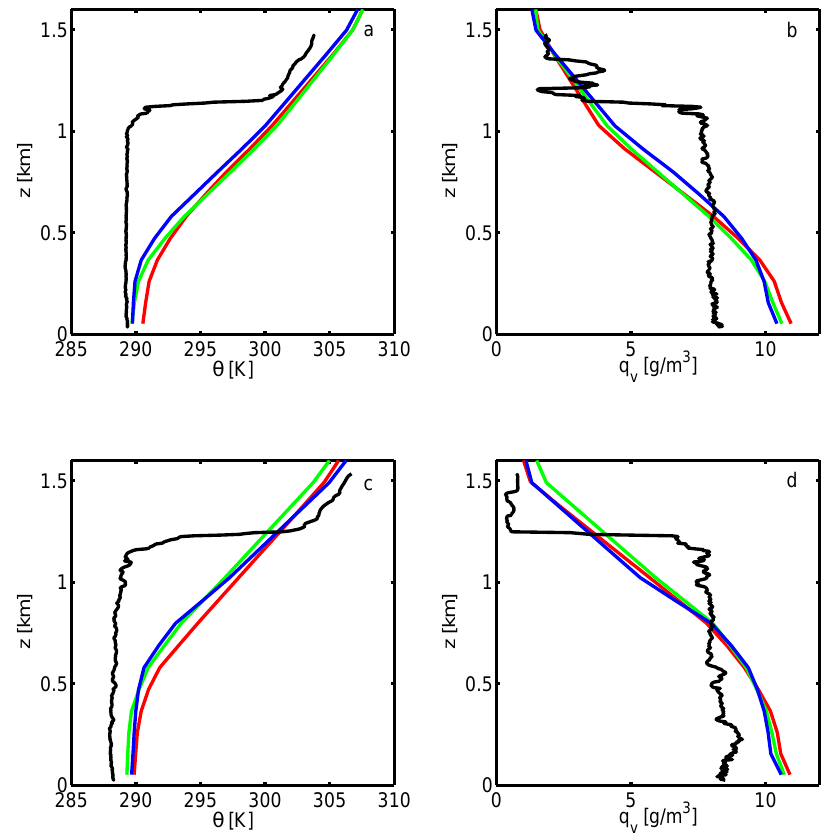
Fig. 7. GFS profiles of the θ and q v for location 2 (upper panels) and location 5 (lower panels) for 12 November for 00:00UTC – blue, 12 November for 12:00UTC – green, and 13 November for 00:00UTC – red. Black lines show profiles measured by the BAe-146.